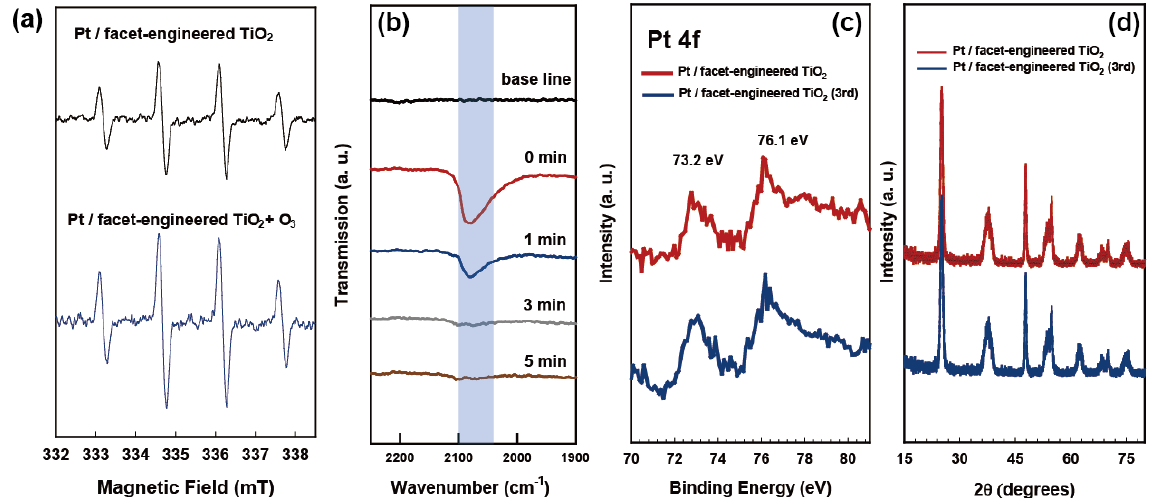
Figure 5. ( a ) Time-dependent profiles of photocatalytic oxidation of CO on Pt/facet-engineered TiO 2 in several different initial ozone concentrations. ( b ) Repeated photocatalytic oxidation cycles of CO on Pt/facet-engineered TiO 2 in several different initial ozone concentrations.